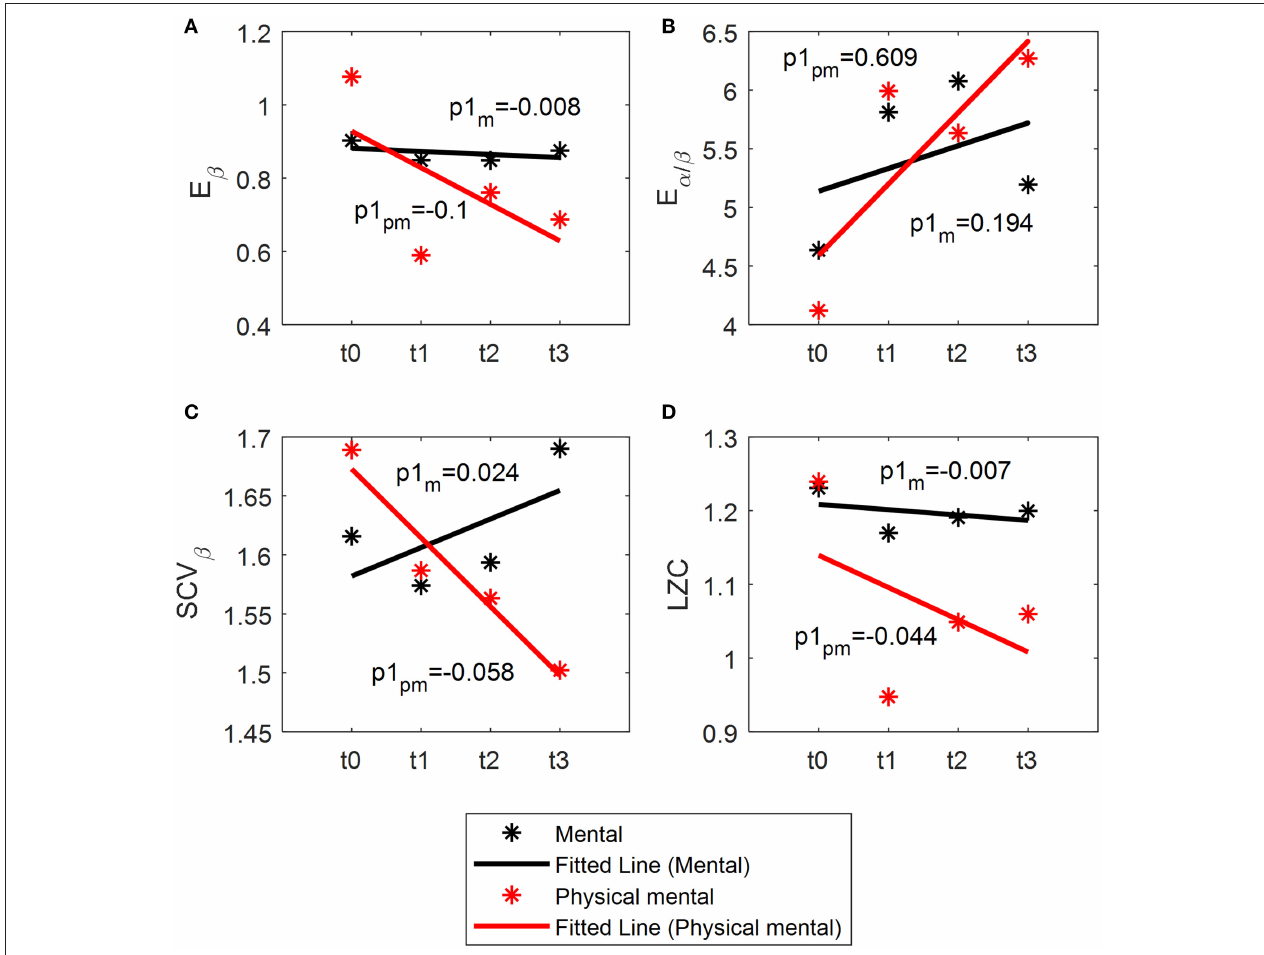
FIGURE 7 | Linear fit of E β (A) , E α/β (B) , SCV β (C) , and LZC (D) . p1 m : the slope of the index for mental task. p1 pm : the slope of the index for physical-mental